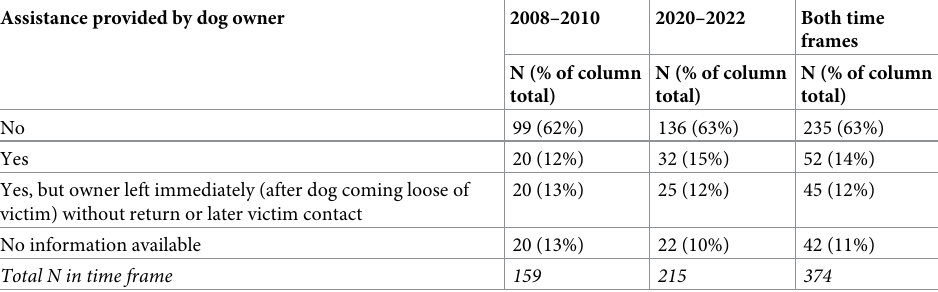
Table 5. Descriptive data on dog owners providing assistance at the biting incident preceding confiscation of 374 dogs. Descriptive data on dog owners providing (‘yes’) or not providing (‘no’) assistance to victim(s) of biting inci- dents leading to confiscation of 374 dogs, as counts and as % of column total for a first time frame (2008–2010), a sec- ond time frame (2020-mid-May 2022) and overall for both time frames. Assistance provided by dog owner